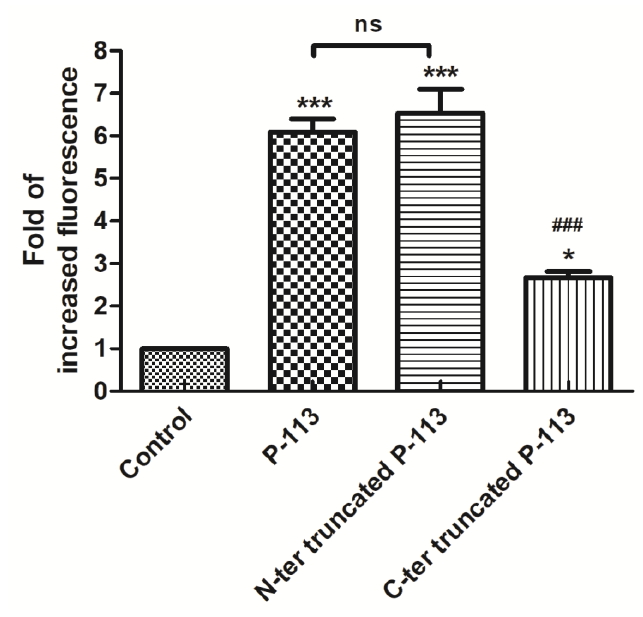
Figure 9. Fluorescence of C. albicans FITC P-113, FITC N-terminal truncated P-113, and FITC C-terminal truncated P-113 groups determined by flow cytometry analysis and expressed as fold increase compared to the control group incubated with FITC only. C. labicans (5 × 10 6 CFU/mL) was incubated at 28 ℃ for 30 min with 50 μM of FITC P-113 or their derivatives. The results are presented as the means ± standard deviations ( n = 3) of three independent experiments. * p < 0.05, *** p < 0.001 compared to the control group; ### p < 0.001 compared to P-113; ns = no significant difference.